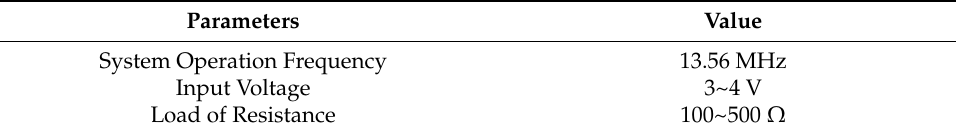
Table 1. System parameters. Table 1. System